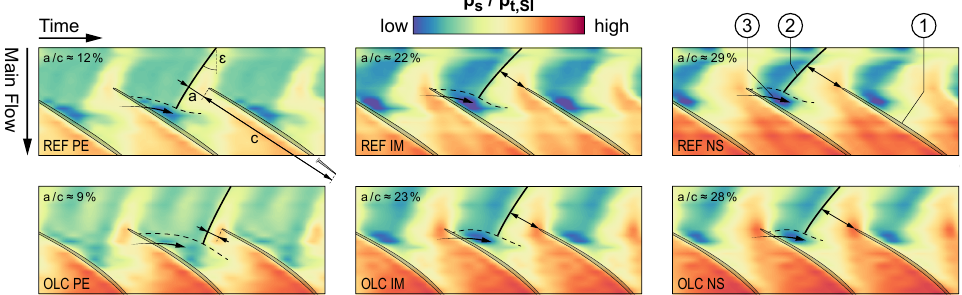
Figure 6. Mean wall pressure data within the rotor tip region for the REF and OLC configurations at DS—operating points PE, IM, and